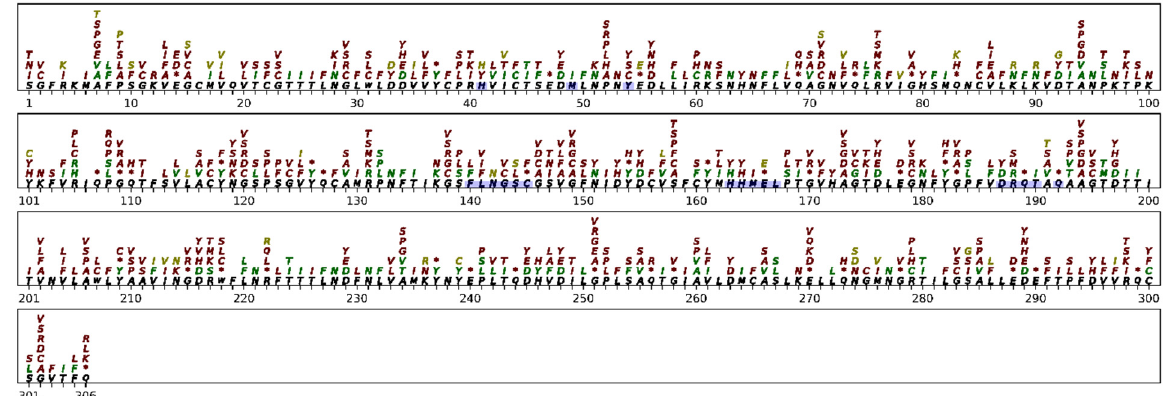
Figure 5. Comparison between M-pro AA changes predicted by our model and changes observed up until January 2022 (NDRL ≥ 45). The reference M-pro AA sequence is shown in black, just above the AA positions. The possible AAs produced by the predicted mutations of NDLR ≥ 15 are stacked over the reference sequence. True positives, false positives, and false negatives are shown in green, red, and dark yellow/gold, respectively. * represents a stop codon, and the same AA represents a synonymous mutation. The AAs with a blue background correspond to the subsites S1, S1 ′ , S2, and S3.